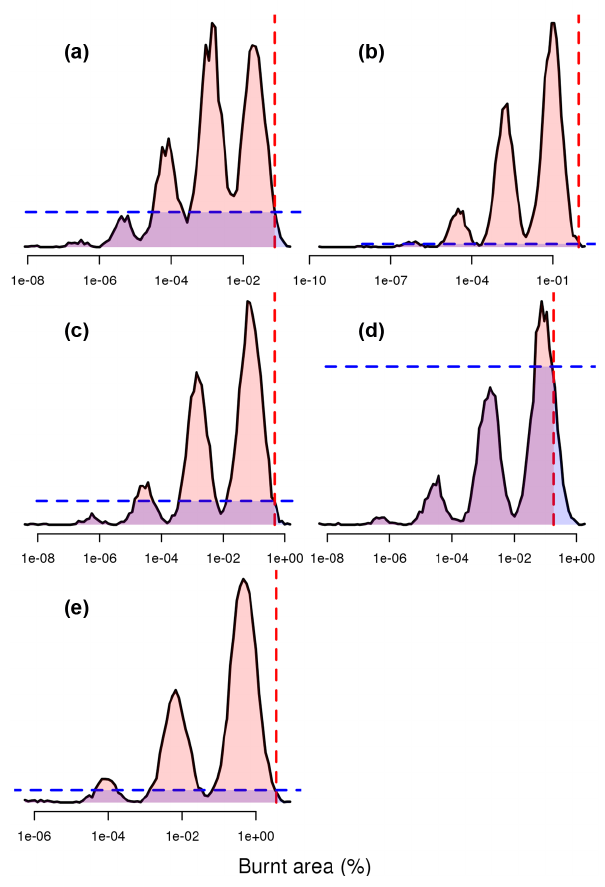
Figure B3. As Fig. B1 but for August